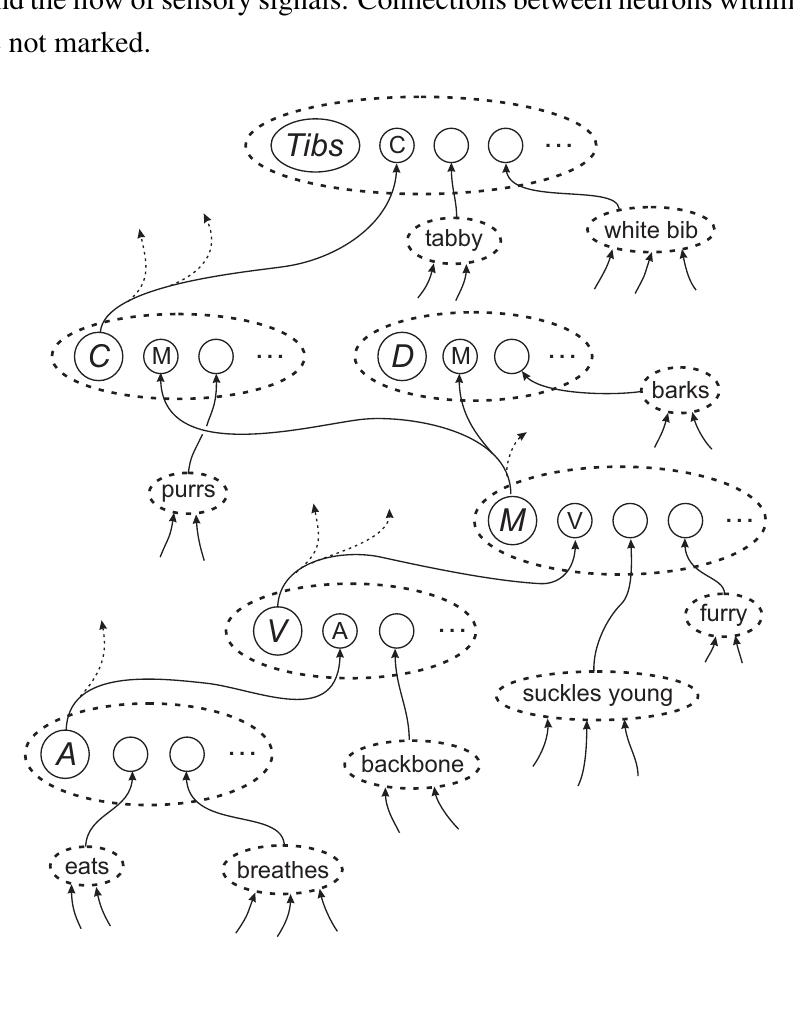
Figure 31. Schematic representation of hypothesised neural analogues of SP patterns and their inter-connections. Key : “C” = cat, “D” = dog, “M” = mammal, “V” = vertebrate, “A” = animal,